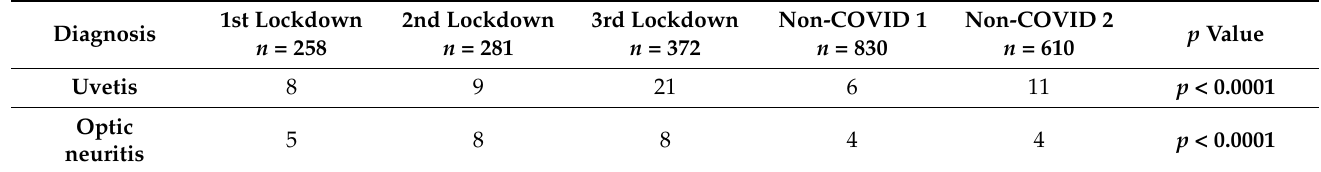
Table 5. Immune-mediated disorders with increasing prevalence in COVID-19 lockdowns (1st: